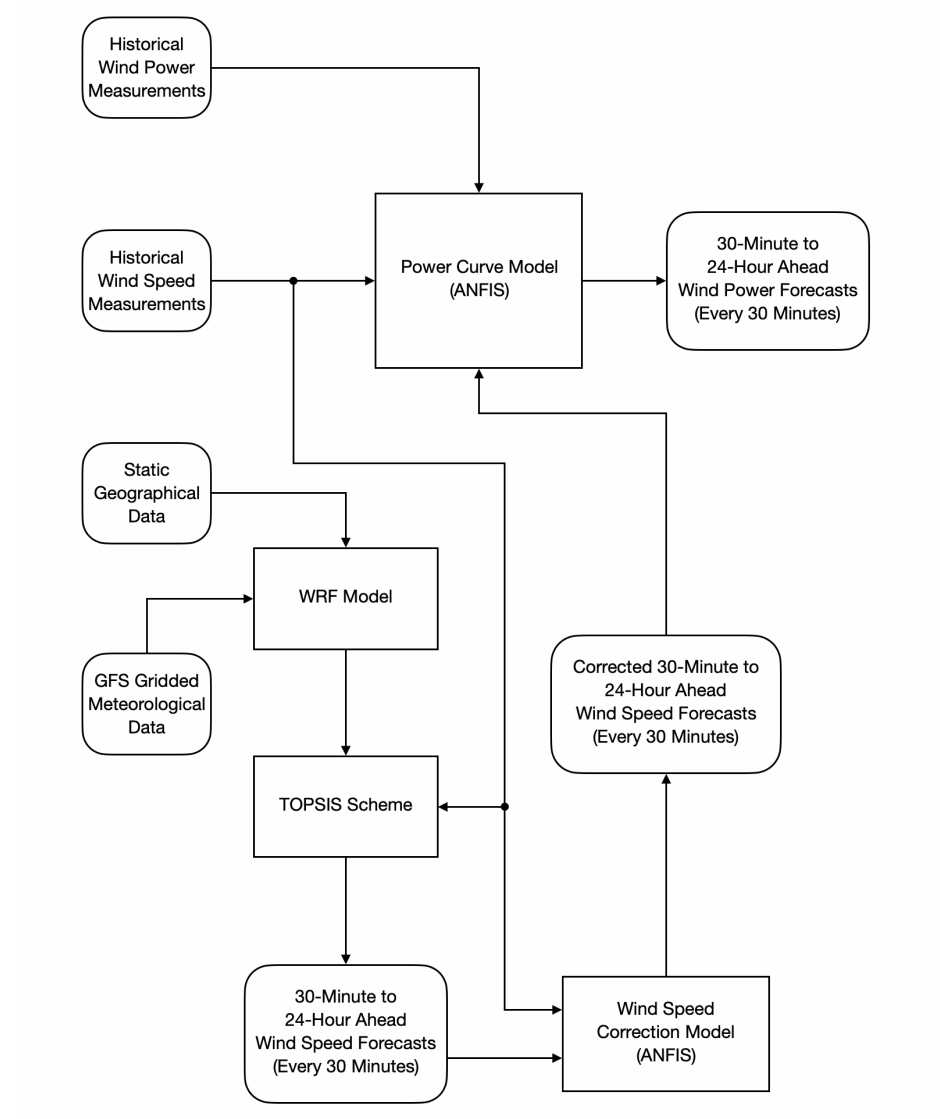
Figure 4. Architecture diagram of the multi-hour ahead wind power forecasting